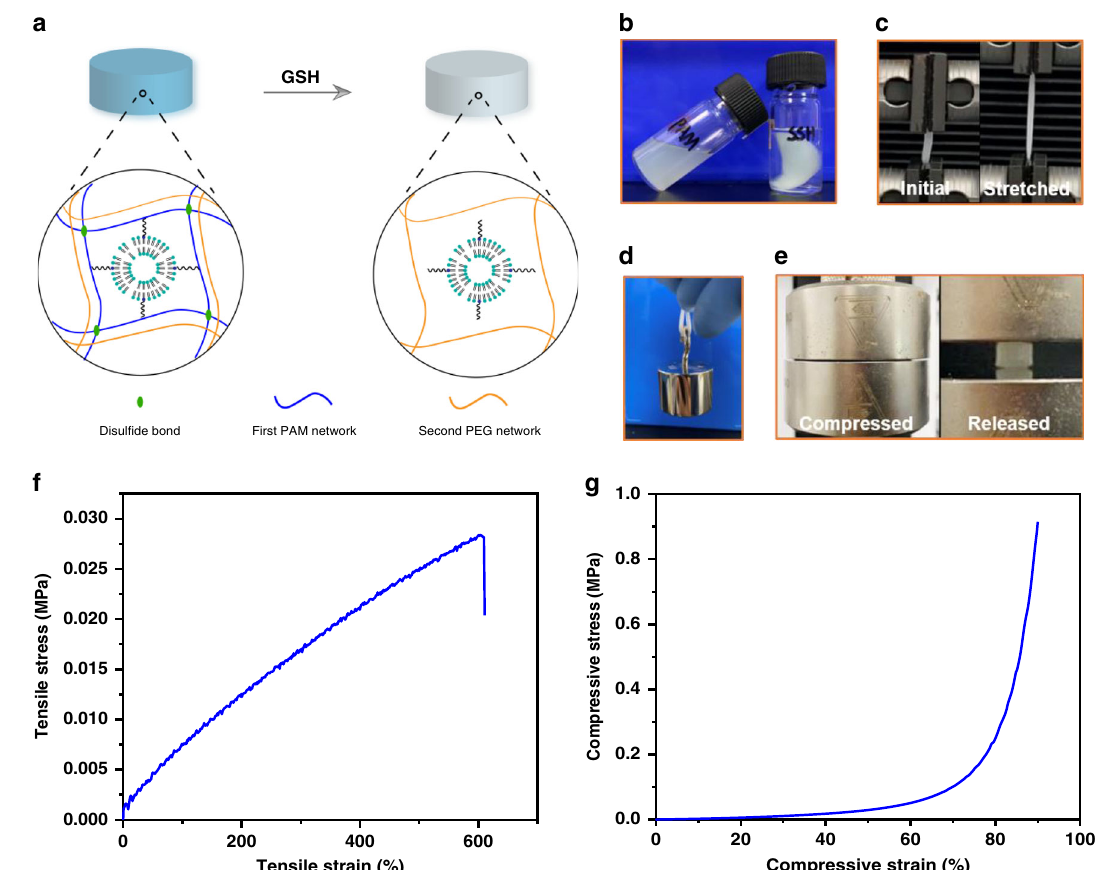
Fig. 5 Design, preparation, and mechanical testing of the second network. a Schematic illustration for the preparation of the second network via GSH- triggered dissolution of the disul fi de-crosslinked polyacrylamide (PAM) network. The reduction-responsive PAM network was synthesized by using N , N ’ - bis(acryloyl)cystamine as a crosslinker. b – e Photographs of different samples. b PAM single-network hydrogel (left) and triggerable swelling-strengthening hydrogels (SSH) (right) samples after soaking in 250 mM GSH for 1 day. c A triggerable SSH strip stretched to its maximal tensile strain. d A